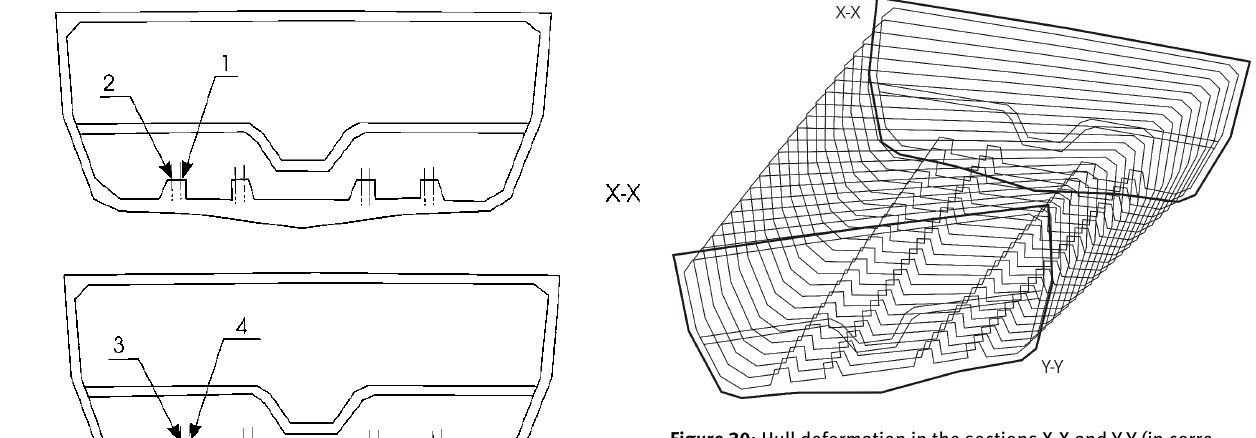
Figure 30: Hull deformation in the sections X-X and Y-Y (in corre- spondence to the screw joints of the oil-pressure rotary actuators